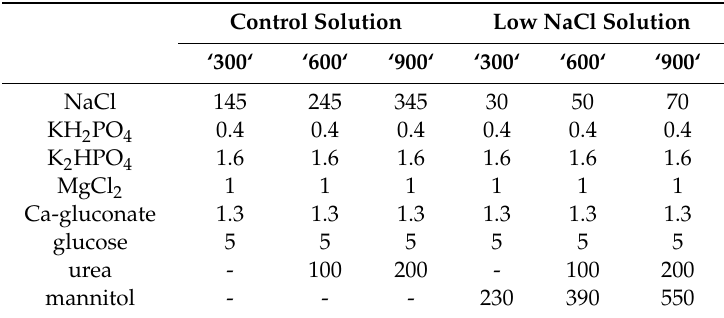
Table 1. Composition of experimental solutions used in Ussing chamber experiments. Concentrations are given in mmol / L. pH was adjusted to pH 7.4.